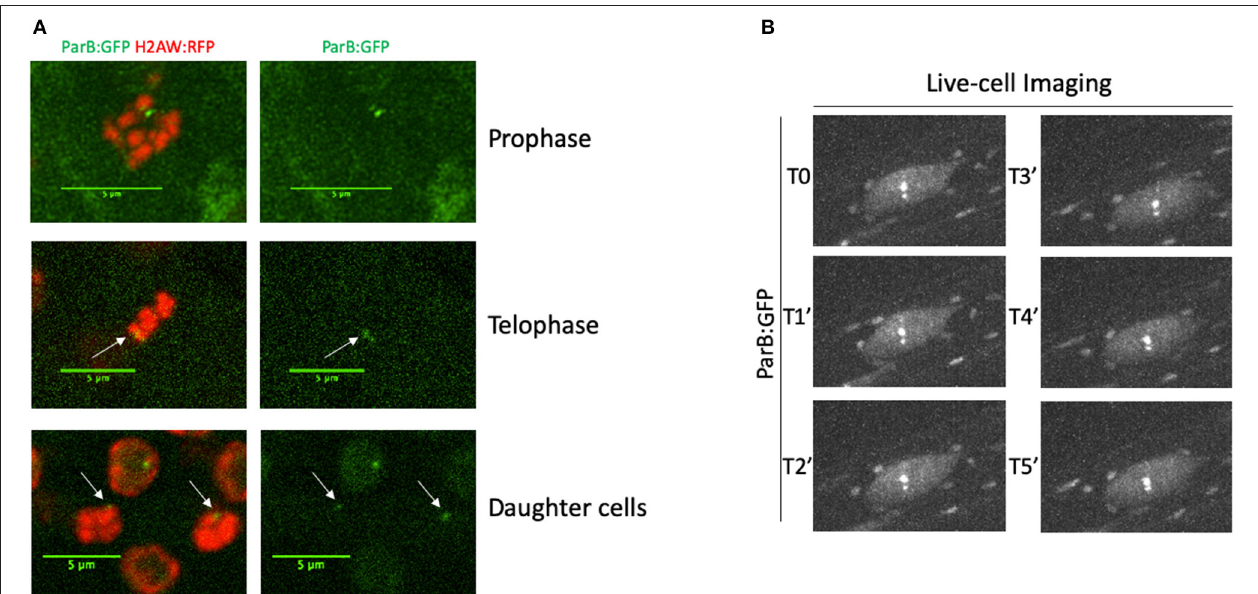
FIGURE 4 | Monitoring parS-ParB:GFP in live cell during mitosis or during a time-course. (A) Detection of parS -ParB:GFP foci (green) and H2A.W:RFP (red) in mitotic cells. Scale bars = 5 µ m. (B) ANCHOR system enables time-lapse tracking of a single locus in live roots by confocal imaging. Time-lapse acquisition of parS -ParB:GFP signals (gray) in an endoreplicated root cell over 5min.